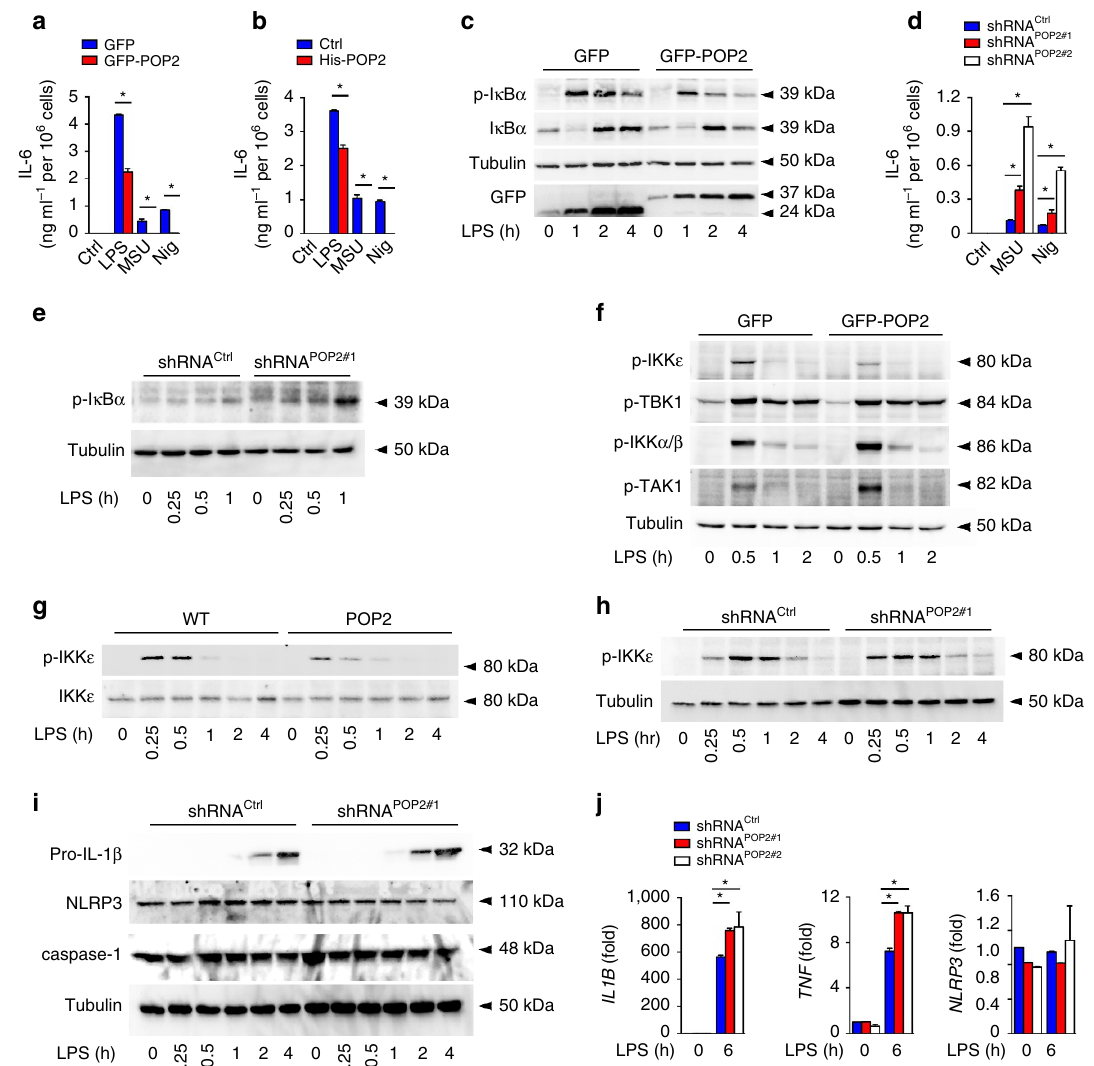
Figure 5 | POP2 inhibits inflammasome priming in human macrophages. ( a , b , d ) Analysis of culture SN for IL-6 release by ELISA in response to LPS, MSU crystals and nigericin in ( a ) GFP and GFP-POP2-stable THP-1 cells, ( b ) control and His-POP2-stable THP-1 cells and ( d ) control (shRNA Ctrl ) and POP2 shRNA (shRNA POP2#1 , shRNA POP2#2 ) expressing THP-1 cells. ( c , e – i ) Immunoblot analysis of phosphorylated and non-phosphorylated proteins in response to LPS treatment of ( c , f ) GFP and GFP-POP2 ( e , h , i ) control and POP2 shRNA-expressing stable THP-1 cells and ( g ) WTand POP2 BMDM for the indicated times. Tubulin protein levels were used as a loading control and GFP to detect expression of GFP and GFP-POP2. ( j ) Real-time PCR analysis of the indicated transcripts in control shRNA, POP2#1 shRNA and POP2#2 shRNA-expressing THP-1 cells in response to LPS induction presented as fold compared to untreated control shRNA cells. Three independent repeats were performed for each experiment. Significance was calculated by a standard two-tailed unpaired t -test and error bars represent s.e.m., * P o